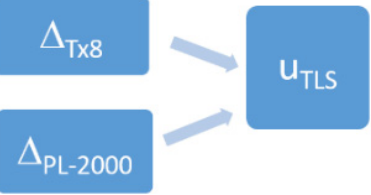
Figure 13. Algorithm of the terrestrial laser scanning (TLS) method accuracy estimation, where: ∆ Tx8 and ∆ PL-2000 are absolute errors corresponding the Trimble Tx8 laser scanner and PL-2000 national system, respectively. u TLS —uncertainty of the considered method.